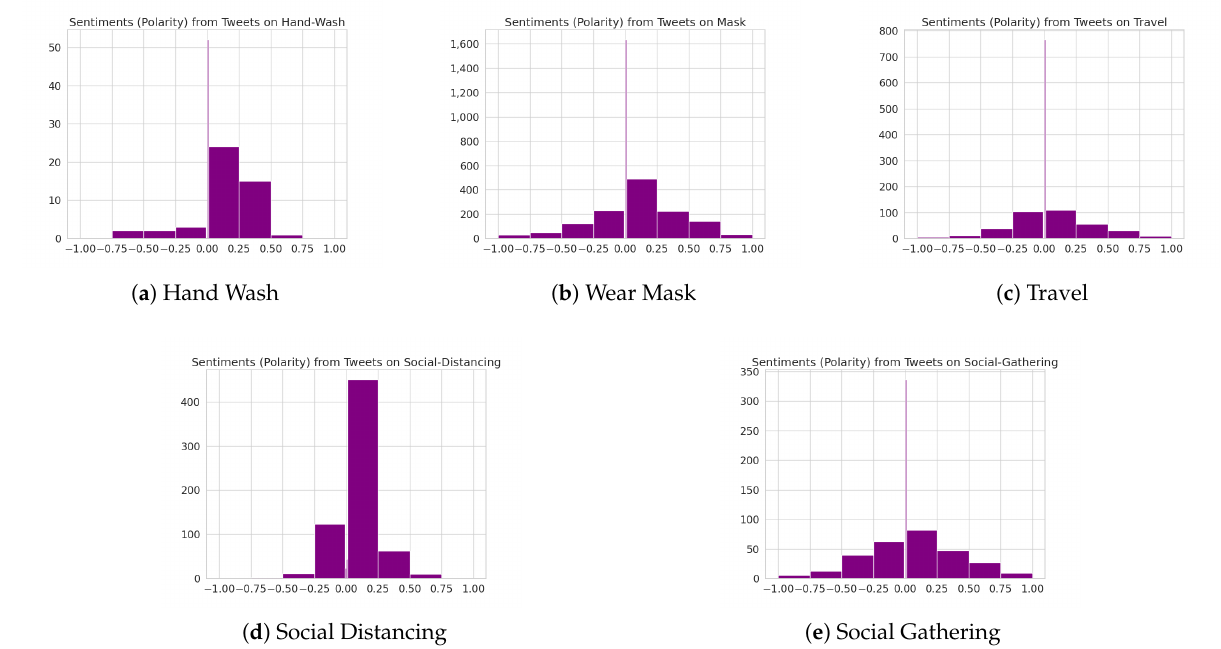
Figure A4. Polarity score of public sentiment for Twitter Dataset 2 on